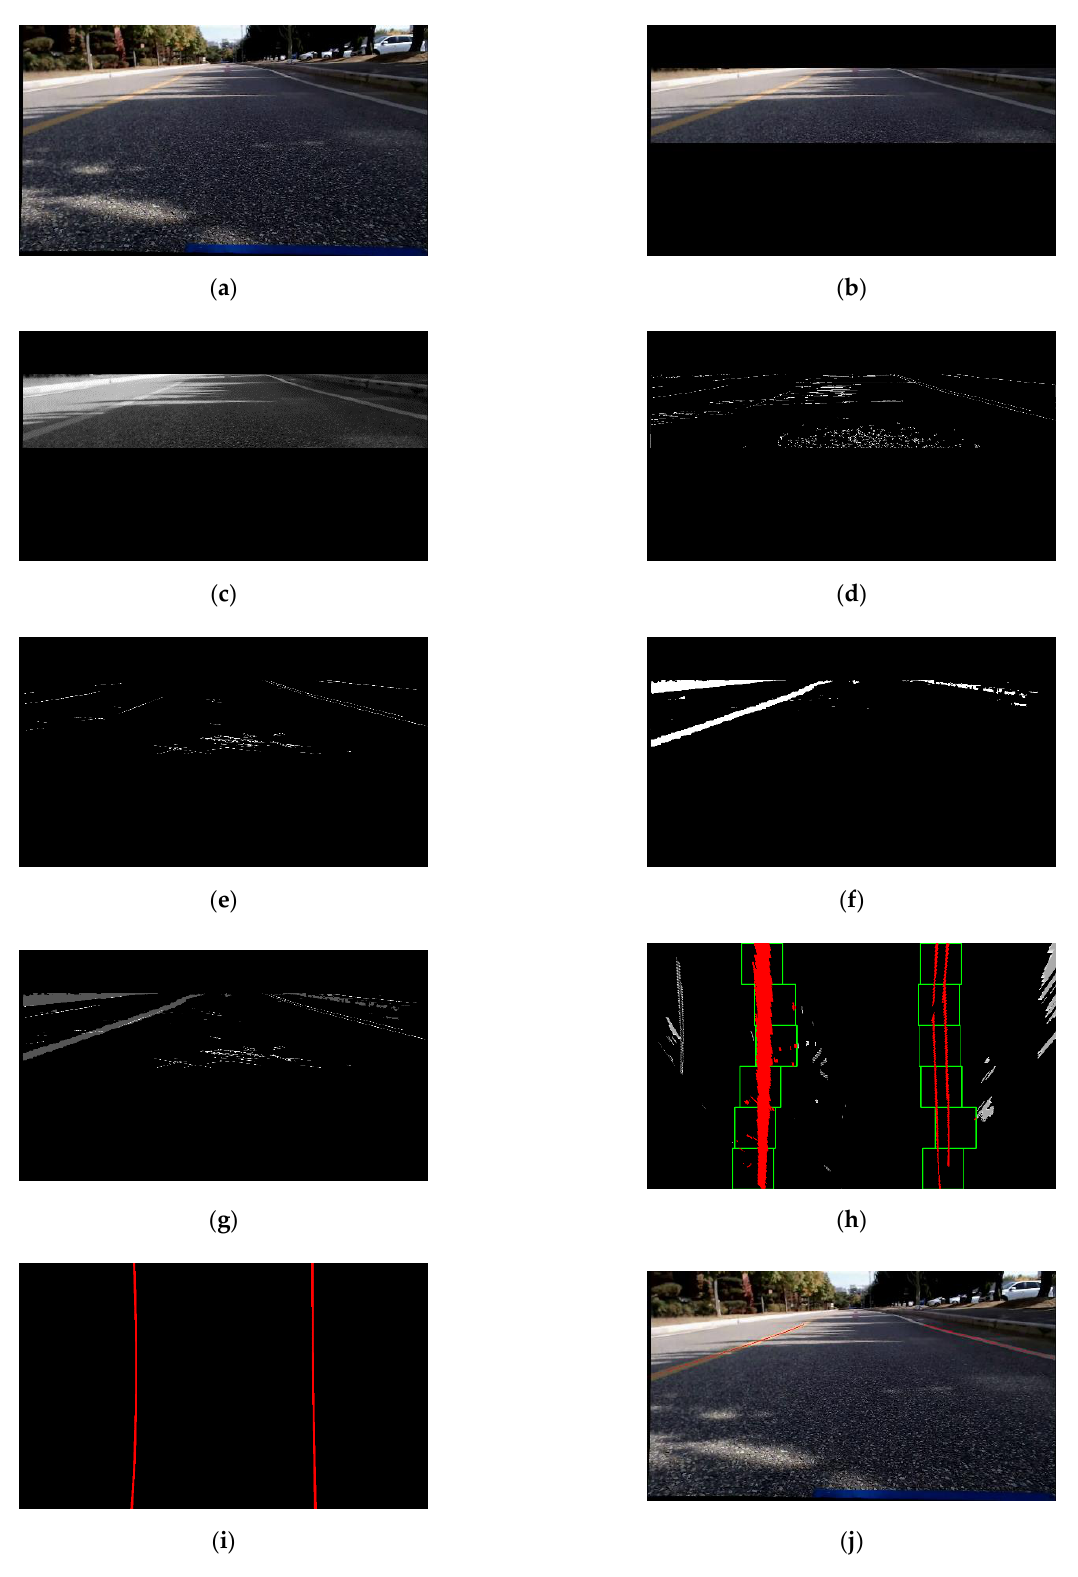
Figure 2. Illustration of the steps involved in lane detection: ( a ) the input image, ( b ) selection of the appropriate ROI in the input image, ( c ) the image obtained via grayscale conversion, ( d ) the edge-detected image, ( e ) the image obtained via filtering following Hough transform, ( f ) the color-detected image after conversion into the HSV format, ( g ) the combination of the straight-line-detected image and the color-detected image, ( h ) the identified lane following the perspective transform, ( i ) the generated lane following quadratic curve fitting, ( j ) the final lane-detected